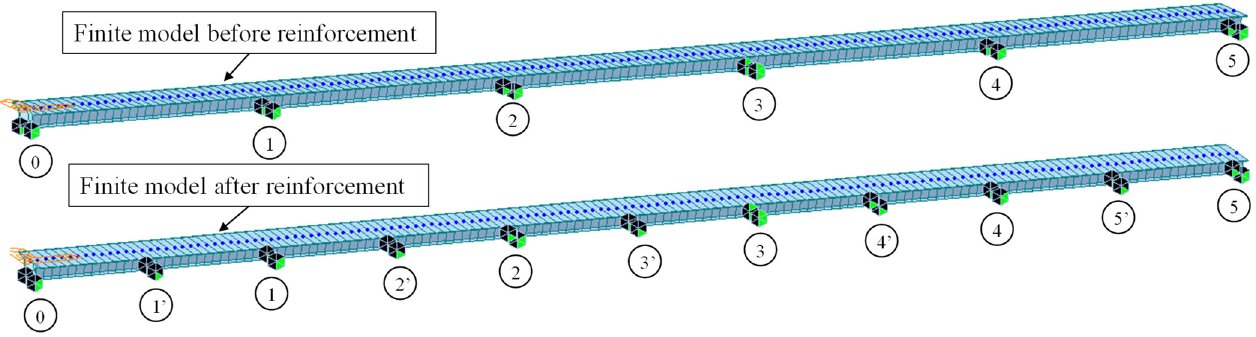
Figure 8. Bridge finite element models.